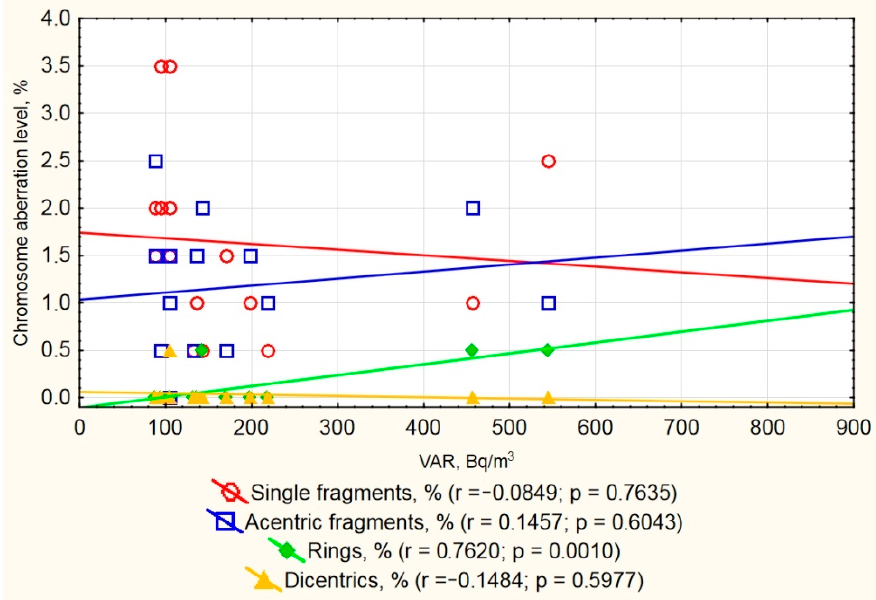
Figure 2. Frequency of chromosome aberrations and residential volume activity of radon (VAR) in studied inhabitants.